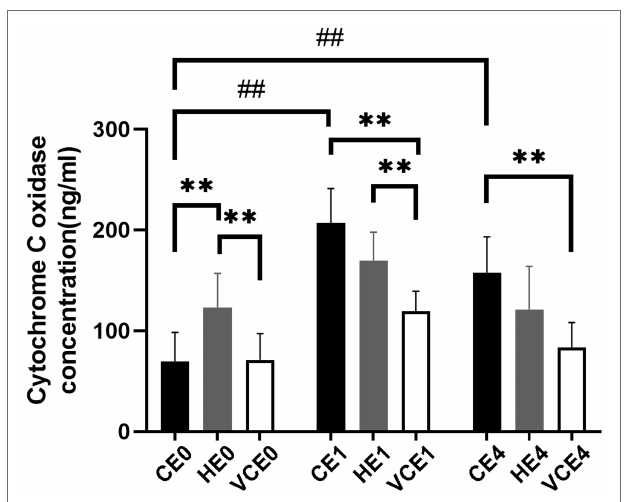
FIGURE 1 | Changes in the level of the mitochondrial respiratory complex IV. C, blank control; H, inhalation of hydrogen gas; VC, vitamin C supplementation; E0, baseline; E1, immediately after exercise; and E4, 4 h after exercise. n = 8 per group. ** p < 0.01; ## p <